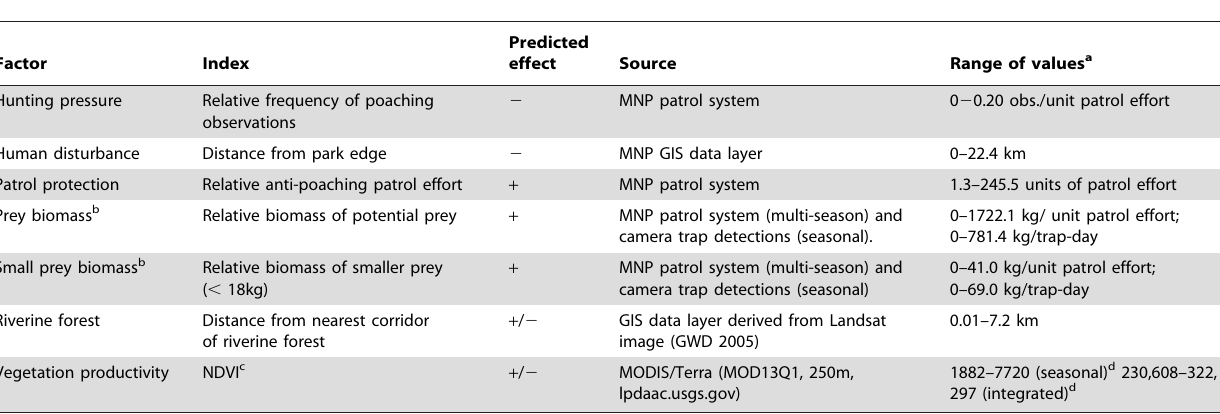
Table 1. Factors hypothesized to influence patterns of carnivore occurrence in Mole National Park (MNP), with the corresponding index used, predicted direction of effect (i.e., negative or positive influence on occurrence, or both), source of data, and range of values across sampled